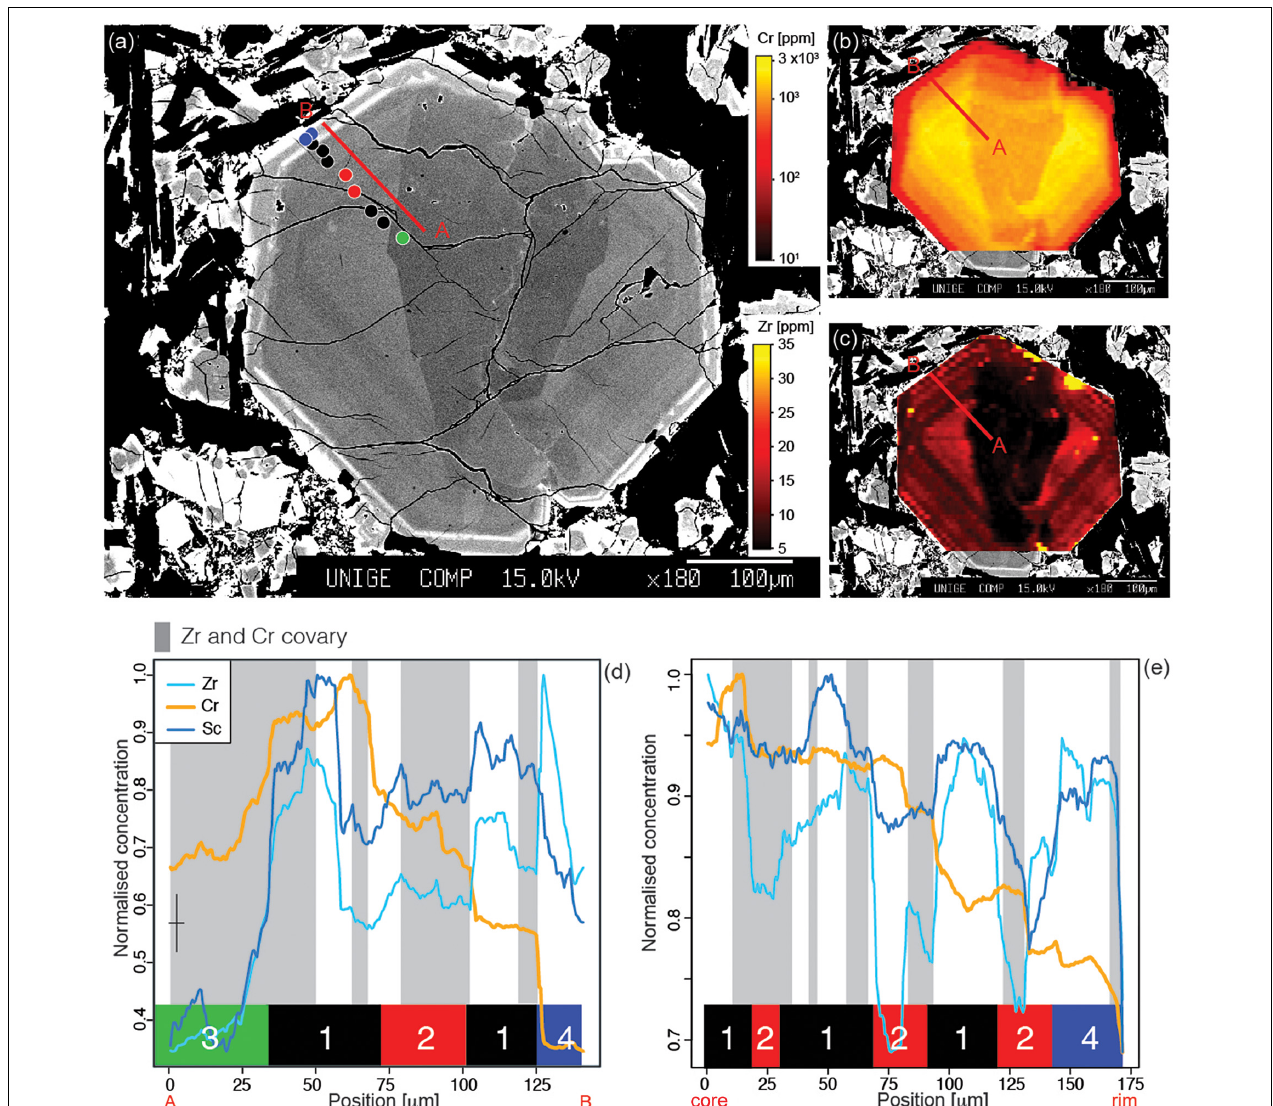
FIGURE 9 | Trace element mapping. (a) BSE image showing the location of the transect over which the trace element content was calculated starting from the elemental maps. The circles indicate the location of the electron microprobe analyses and the color indicates the corresponding cluster identified from major element analyses. (b,c) Maps of Cr and Zr for the crystal in panel (a) . (d) Concentrations of Zr, Cr, and Sc normalized to the maximum and minimum values measured in all profiles, for the crystal shown in panels (a–c) . The colors (and numbers) indicate the corresponding cluster identified with major elements. Panel (e) same as panel (d) but for another